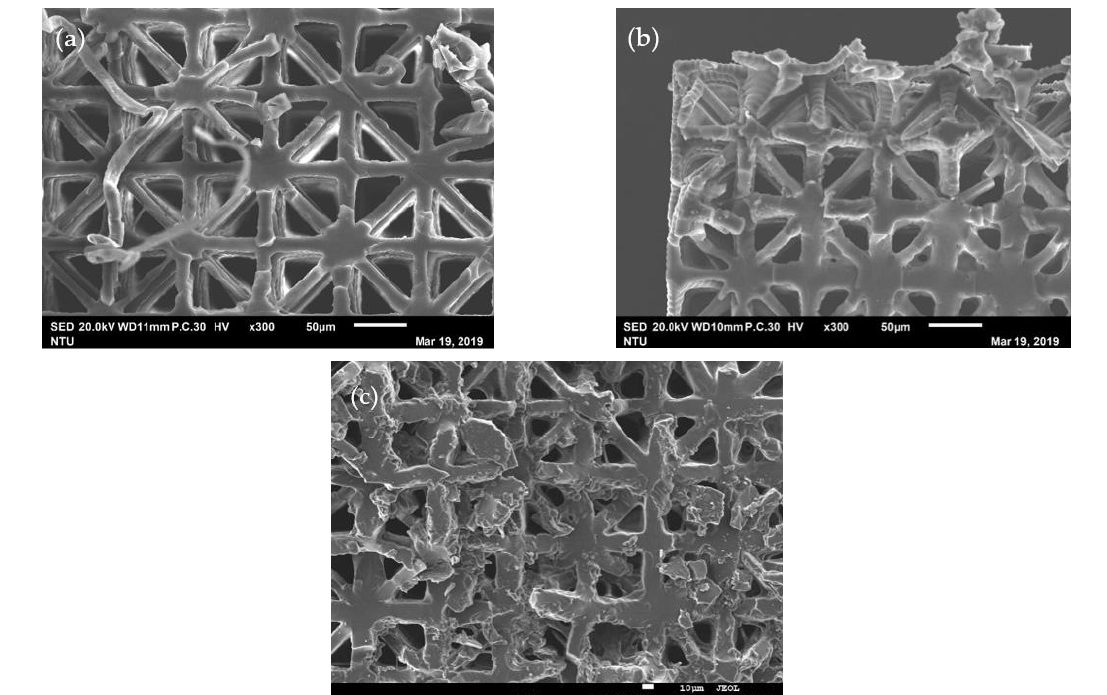
Figure 5. Interior view of the micro-lattice structures with unit cell length L of ( a ) 150 μm; ( b ) 130 μm; ( c ) 100 μm, cut open at about mid-height.